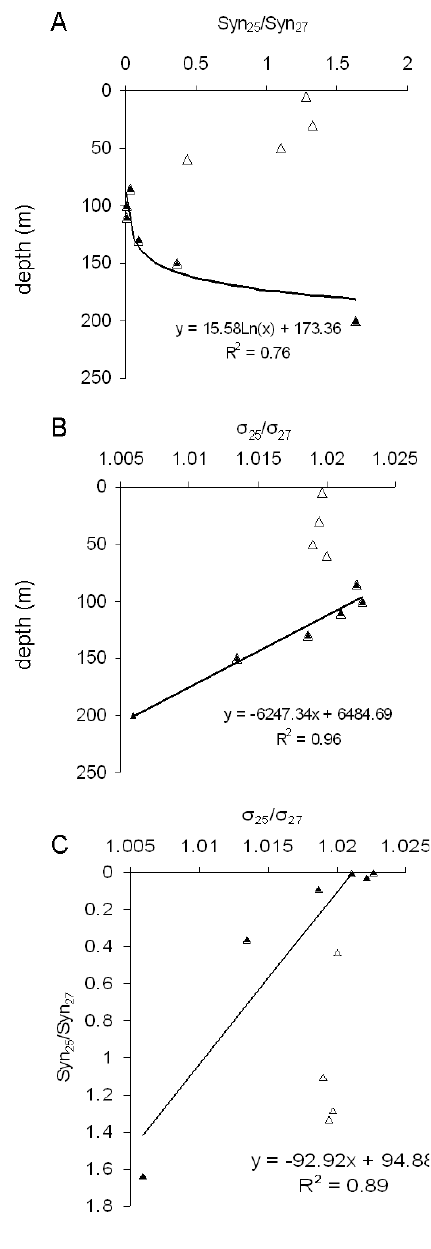
Fig. 9: Relationships between vertical distributions of Synechococcus abundance and density north (station 25) and south (station27) of the thermohaline front. (A) Depth dependence of the abundance ratio Syn 25 /Syn 27 . (B) Depth dependence of the density ratio σ 25 / σ 27 . (C) Relationship between Synechococcus abundance ratio Syn 25 /Syn 27 and density ratio σ 25 / σ 27 .